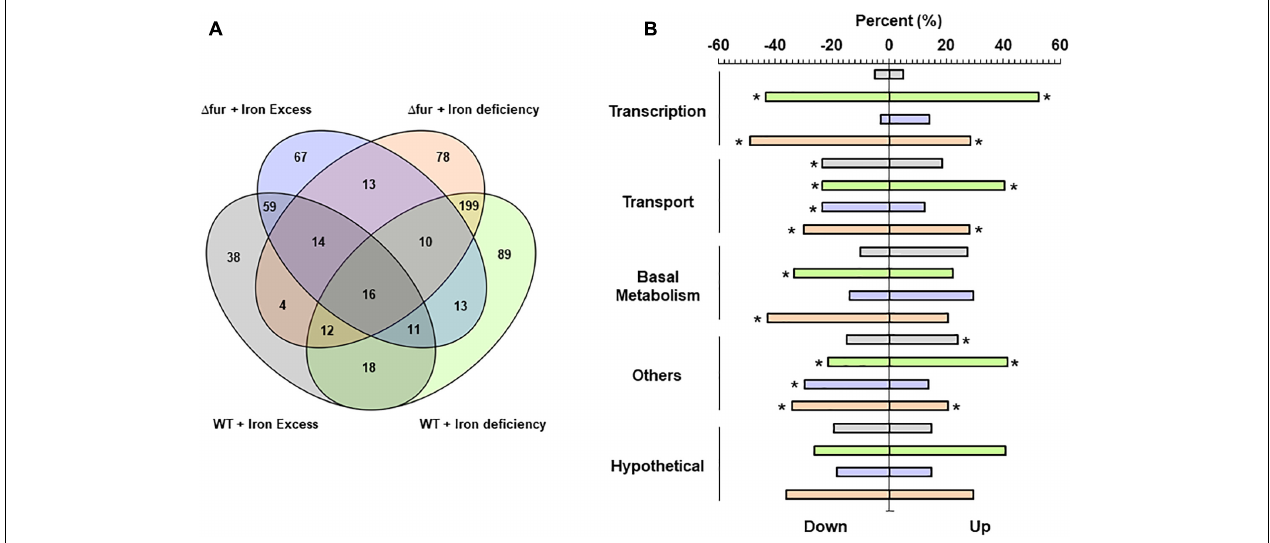
FIGURE 4 | Global transcriptional analysis of E. faecalis wild type and Fur mutant growing at different iron treatments. (A) Venn diagrams. Numbers indicate the total genes activated on each condition. (B) RNAseq differentially expressed genes classify by COG super-class categories. Color bars represent the two E. faecalis strains growing under iron excess or deficiency. Asterisk denotes significant enrichment ( p (0.05) compared to the total proportion in the bacterial genome.